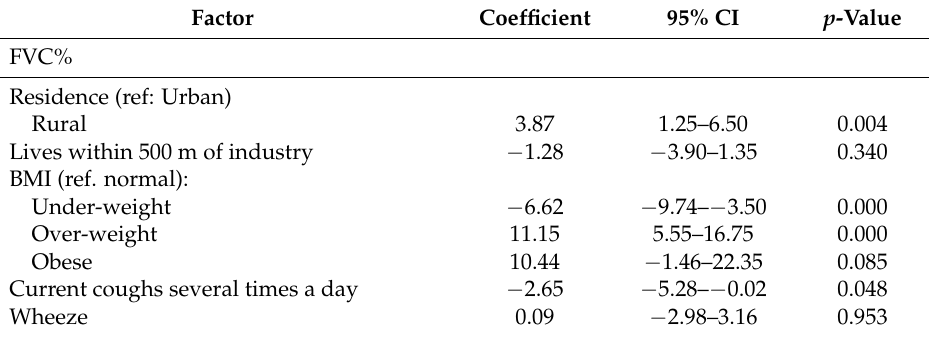
Table 6. Factors associated with FVC%, FEV 1 % and FEF 25–75 % at multivariate stage.